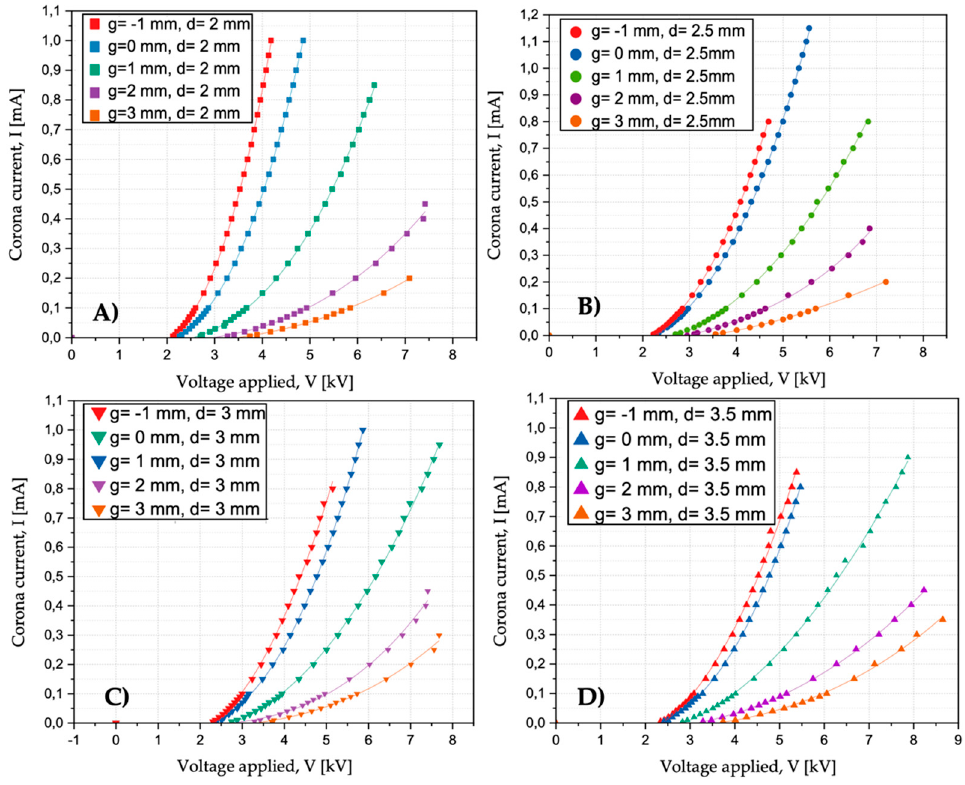
Figure 5. The EMBID configuration with 25 µ m emitting electrode cable with different gaps and distances between ground electrodes of ( A ) 2 mm, ( B ) 2.5 mm, ( C ) 3 mm, and ( D ) 3.5 mm is analyzed using the